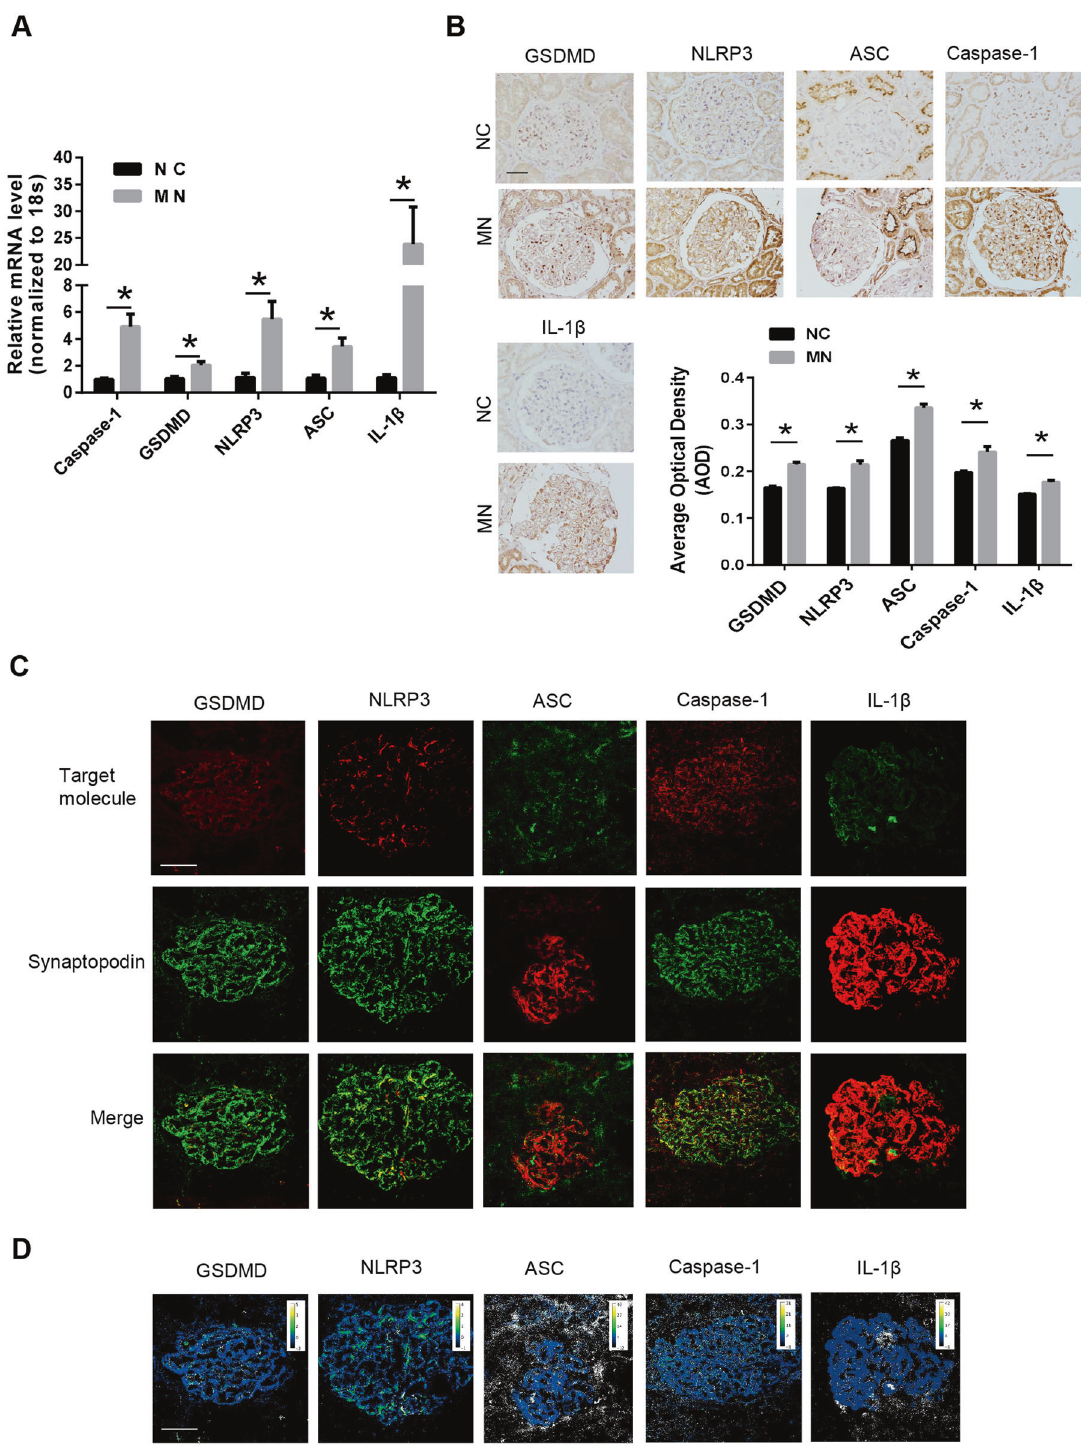
Fig. 1 The presence of pyroptosis in the podocytes of MN patients. A The relative mRNA levels of pyroptosis-related genes in the glomeruli of healthy controls and MN patients. B Immunohistochemical detection of the protein level of pyroptosis-related proteins in renal cortical sections of healthy controls and MN patients (scale bar = 50 μ m). The quanti fi cation of the average optical density is shown in the panel below (12 – 81 glomeruli of each group were analyzed). C The colocalization of pyroptosis-related proteins and synaptopodin in renal cortical sections of MN patients (scale bar = 50 μ m). D The ratios of fl uorescence intensity of pyroptosis-related proteins to synaptopodin of Panel ( C ) were calculated by the ImageJ program (scale bar = 50 μ m). The data represent the mean ± SEM. * p < 0.05.